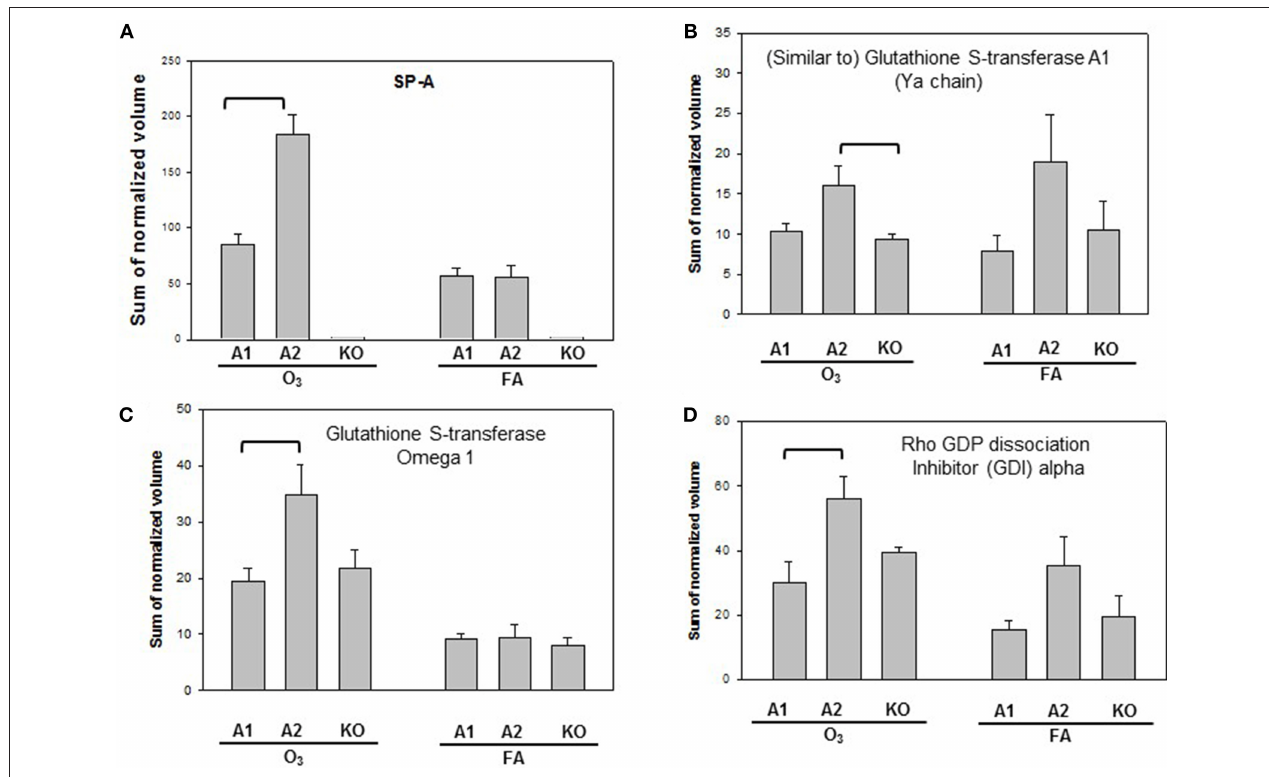
FIGURE 5 | Representative graphs of specific protein changes among genotypes of ozone-exposed male mice. Histograms depict levels of each specific protein, (A) SP-A; (B) (Similar to) glutathione S-transferase A1; (C) glutathione S transferase, omega 1; (D) Rho GDP dissociation inhibitor (GDI) alpha. These proteins exhibit significant differences in one group of comparisons of male mice with different genotypes (A1, A2, KO) after exposure to O 3 and bacterial infection. Comparisons between groups that are statistically significant ( p < 0.05) are indicated with a